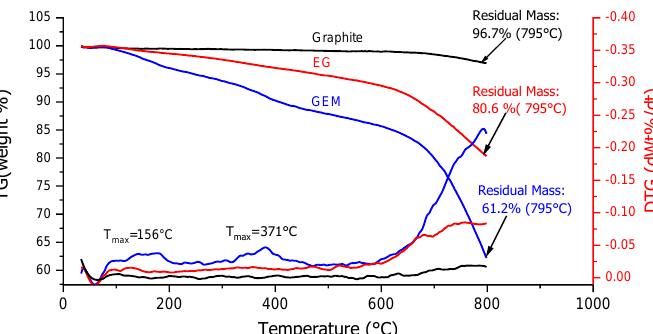
Figure 3. Thermal degradation analyses of graphite (black), graphene (EG) (red) and graphene ethyl maleate (GEM) (blue) weight loss (TG) and weight loss derivative (DTG). The degradation can be attributed to the de-alkylation of esters, which are present from the functionalization and the formation of degradation products and anhydrides. Once exfoliated, the graphene shows a higher weight loss rate with a similar behavior, probably being the particles smaller they may be carried by the nitrogen flow, in addition to degradation. Similar to the previous sample, the IR analyses of the developed gasses confirms the production of water, CO 2 (FT-IR 750 °C), and a small amount of carbon monoxide that reaches maximum production at a lower temperature (SM Figure S2) due to oxygen impurities present in the sample. The different degradation rate of graphite and graphene are indeed correlated with the techniques used for the preparation of the composite; the sonication method [17,30] increases the oxygen surface functional groups. In contrast, several degradation steps are present in the case of GEM (Figure 4a). The